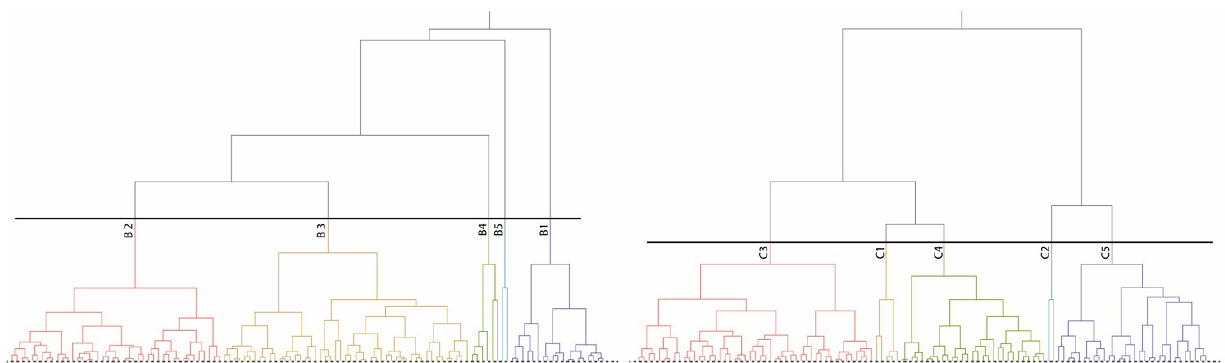
Figure 2. Hierarchical classification. Results: Building types (left) and context types